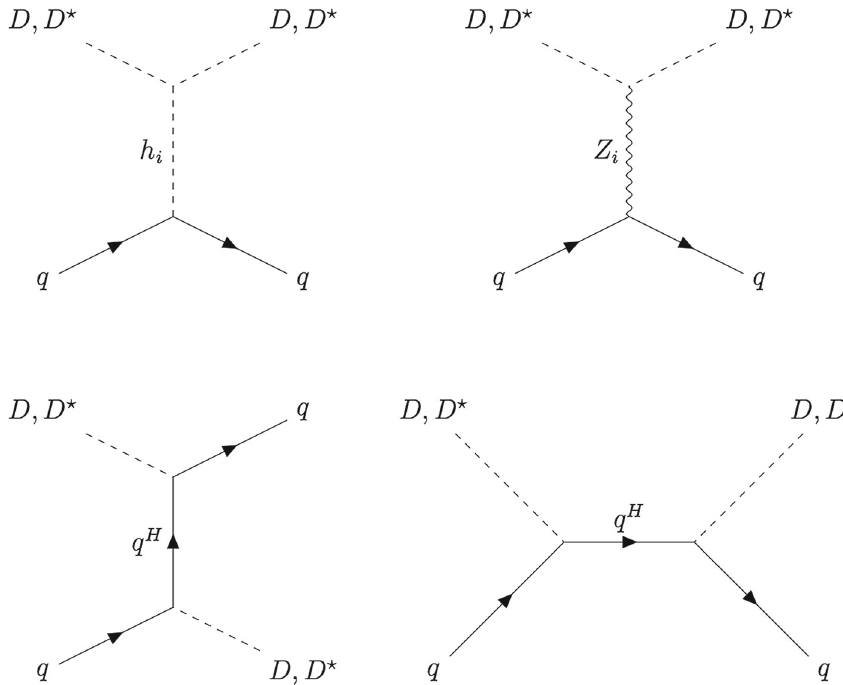
Fig. 1 The Feynman diagrams relevant for DM direct search. They consist of three t-channel diagrams with the Z 2 -even Higgs bosons (top left), neutral gauge bosons (top right) and heavy quarks (bottom left) mediators. There is also s-channel heavy quarks exchange (bottom right)